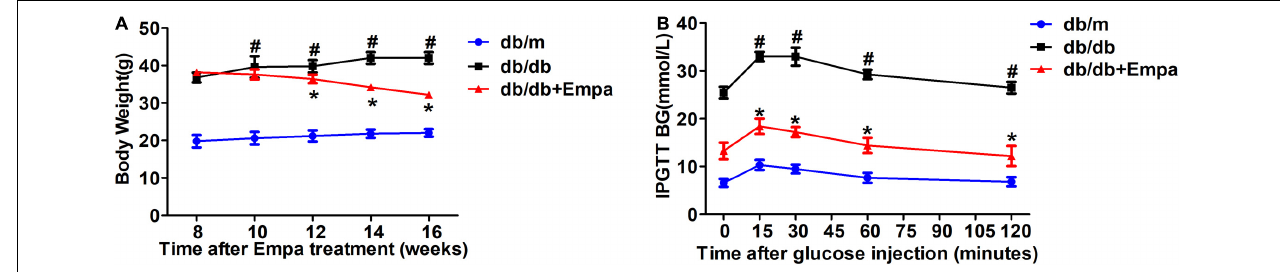
FIGURE 1 | Effects of empagliflozin on blood glucose and body weight. (A) Body weight. (B) Intraperitoneal glucose tolerance test (IPGTT). n = 6 mice/group. * P < 0.05, db/db vs. db/db+Empa; # P < 0.05, db/db vs.